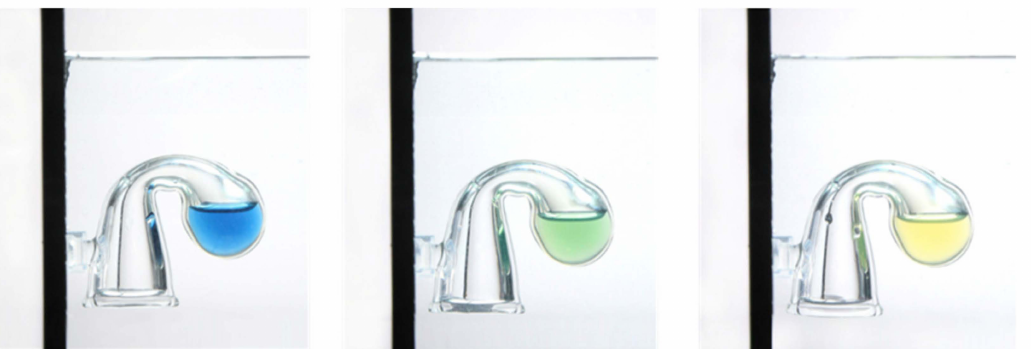
Figure 2. Photographs of the aquaria CO 2 drop checker, manufactured by Fluval Aquatics Ltd., mounted on the inside of a fish tank with the colour of the BTB CO 2 solution ideally indicating ( left ) low CO 2 levels, ( centre ) ‘good’ CO 2 levels, and ( right ) high CO 2 levels. The composition of the Fluval indicator solution is almost identical to that used in Figure